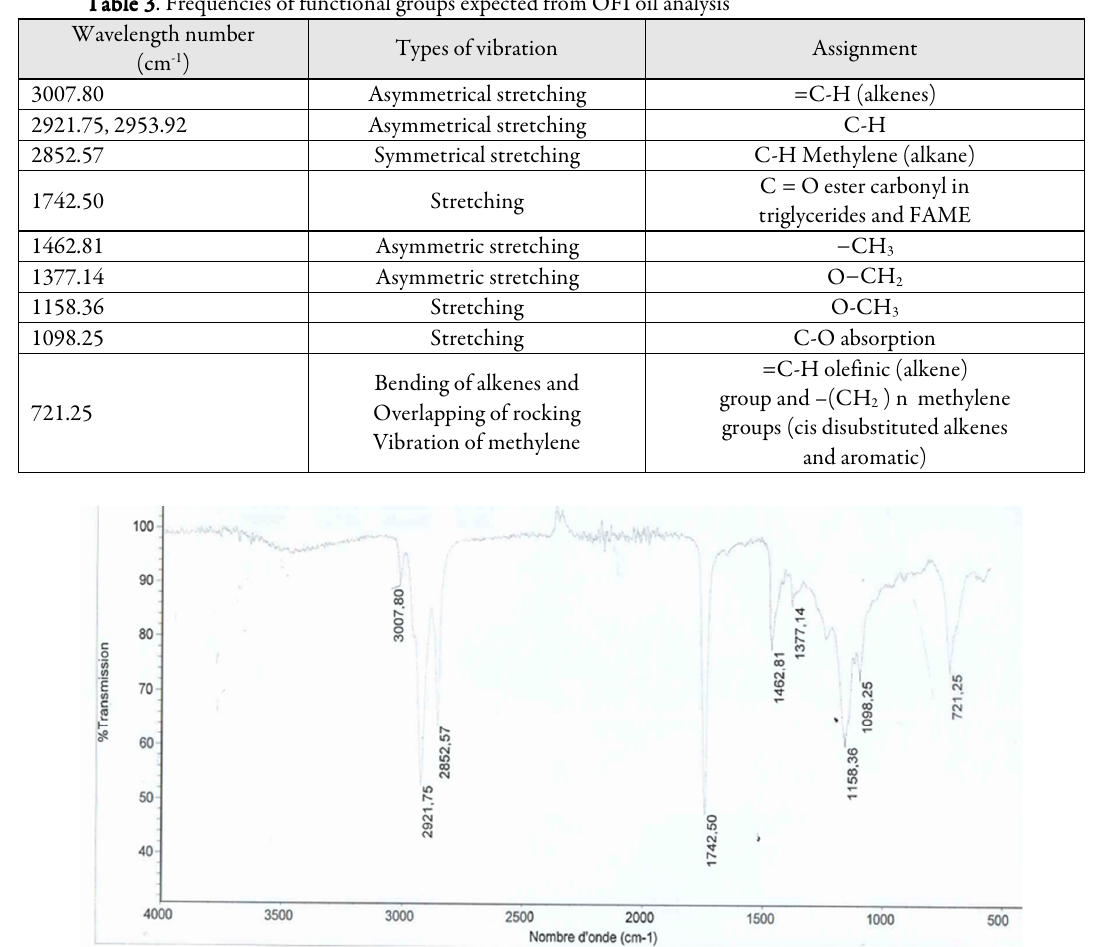
Figure 1. FTIR spectrum of OFI oil